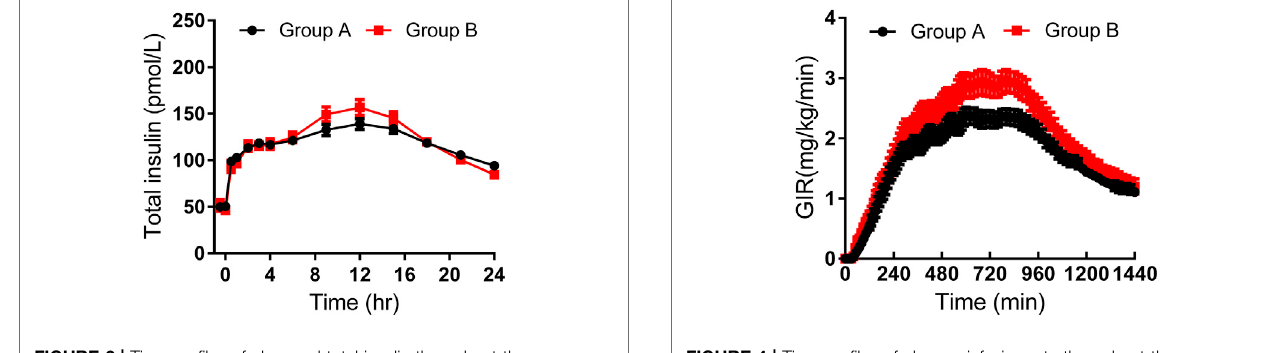
FIGURE 2 | Time-pro fi les of observed total insulin throughout the euglycemic clamp in groups A and B, respectively (Mean ± SEM).